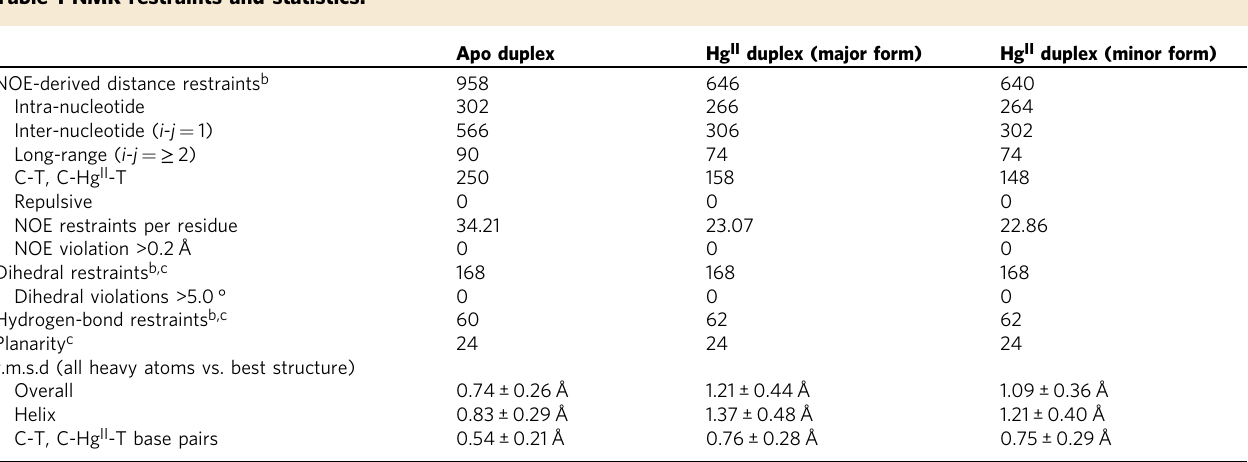
Table 1 NMR restraints and statistics. a